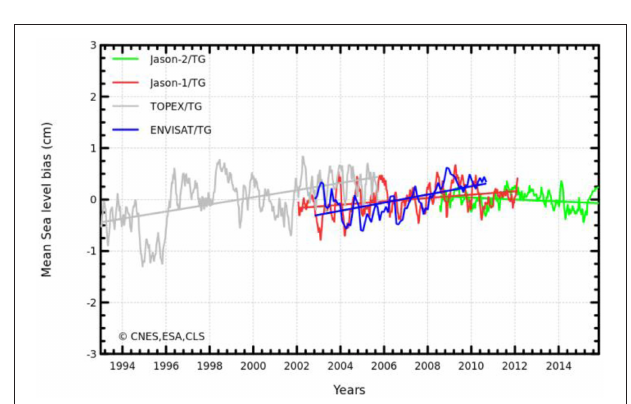
FIGURE 2 | Difference between altimetry sea surface heights and tide gauges in situ measurements for four altimetry missions. Ambiguous values are observed for Envisat for 2002 and 2005 ( Ablain et al.,